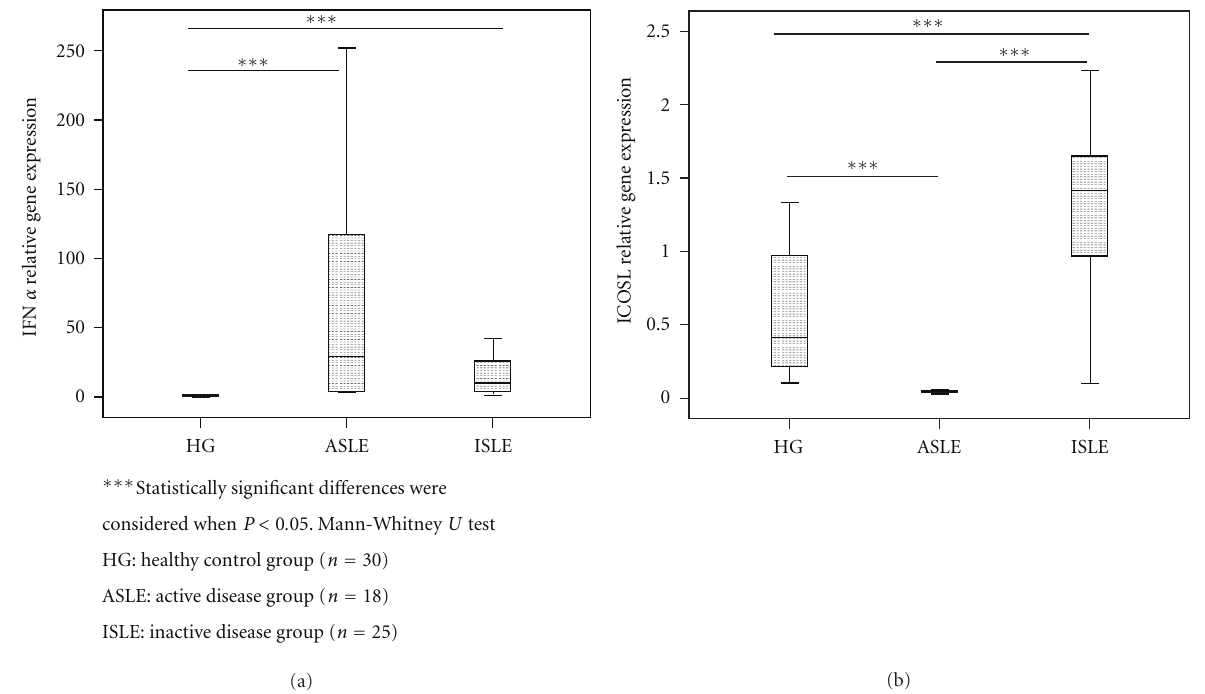
Figure 5: IFN- α and ICOSL relative gene expression in cell-sorted pDCs subset in the three studied groups (HG, ASLE, and ISLE).